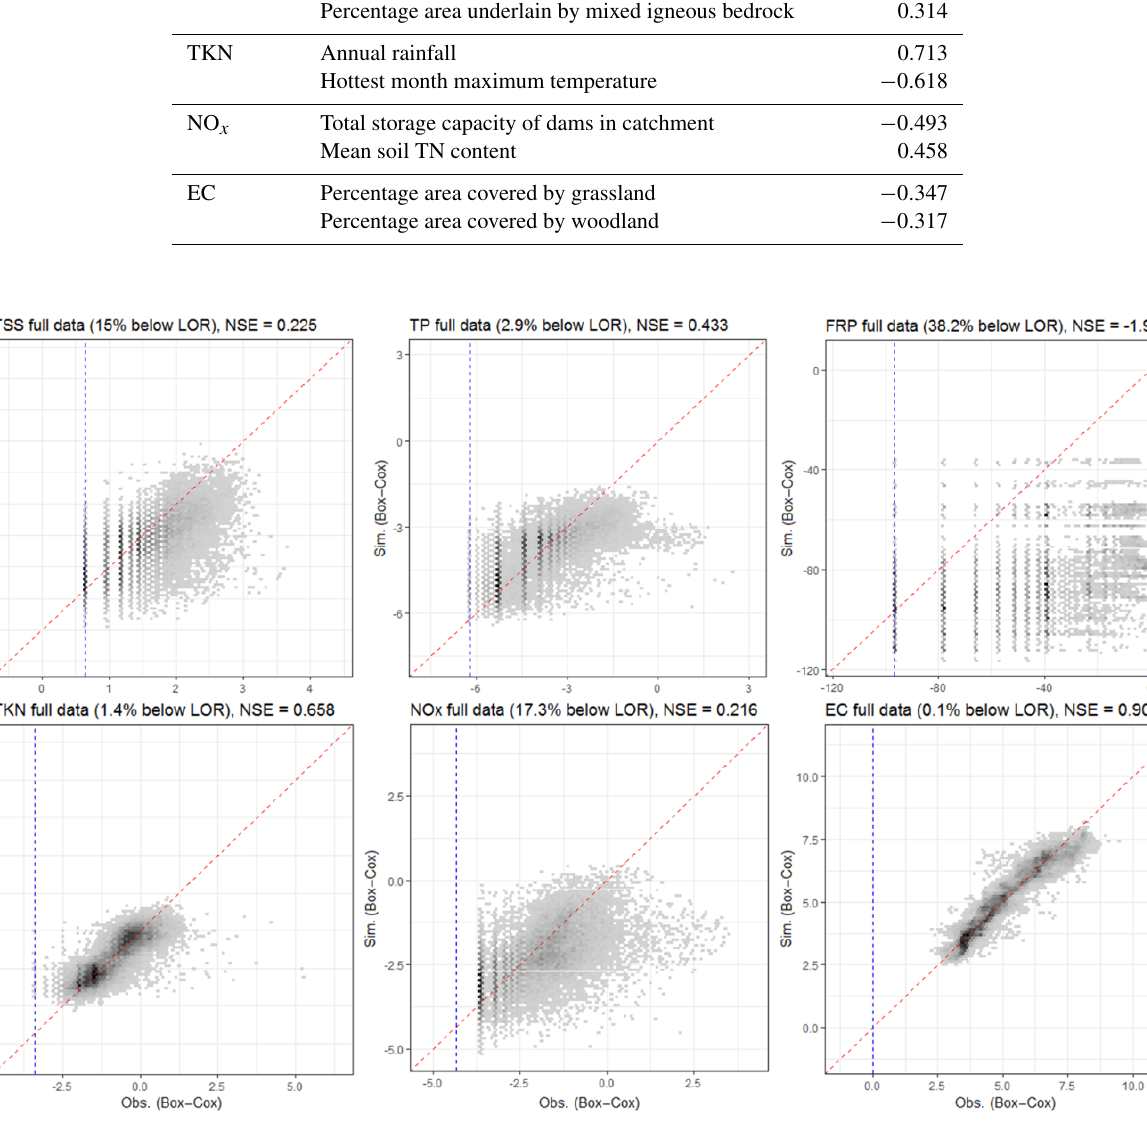
Figure 2. Performance of the spatiotemporal models for each of the six constituents, represented by the simulated median concentrations and corresponding observations of above-DL records across all 102 calibration sites, in Box–Cox-transformed space. Darker regions represent a denser distribution of simulation and observation points, dashed red lines show the 1 : 1 lines and dashed blue lines show the DL levels. For each constituent, the percentage of data below the DL and the model performance (NSE) are also